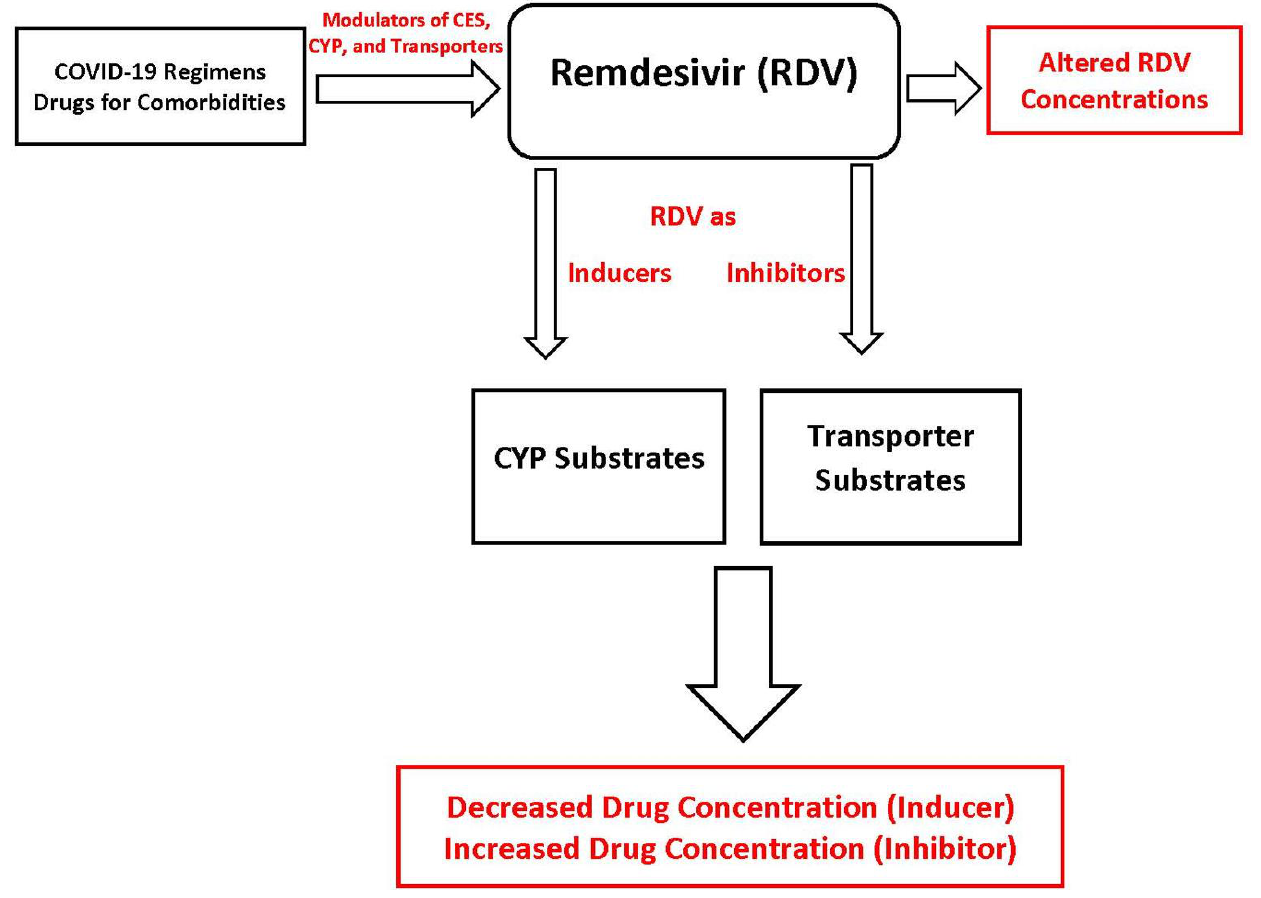
Figure 2. Potential drug-drug interactions involving remdesivir, either as “victim” or “perpetrator”. CYP, cytochrome P450, CES, carboxylesterase.